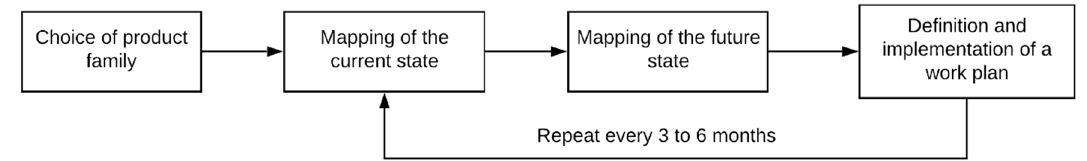
Figure 4. Product system VSM frame of reference [24]) .